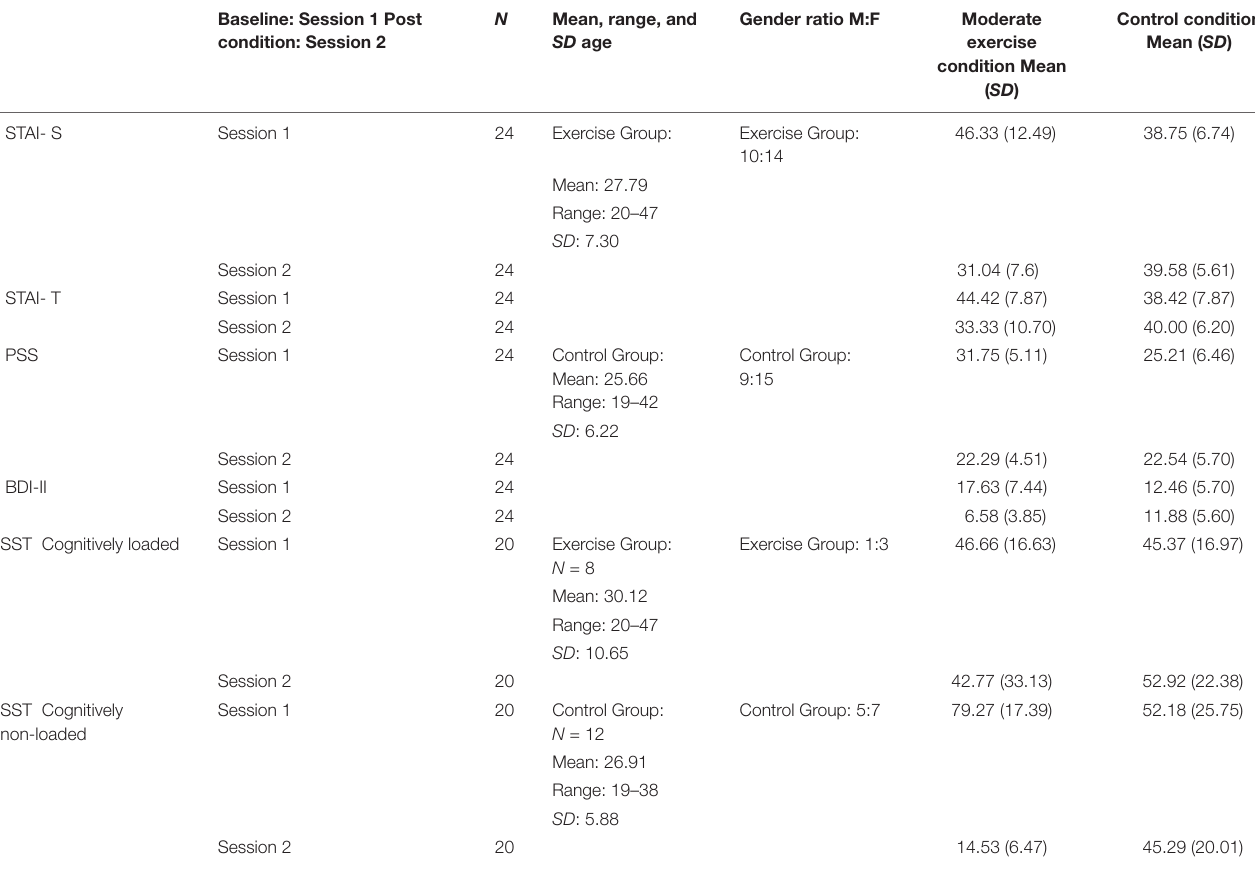
TABLE 2 | Study 2: Means and standard deviations for STAI, PSS, BDI-II, and SST measures for moderate exercise and control